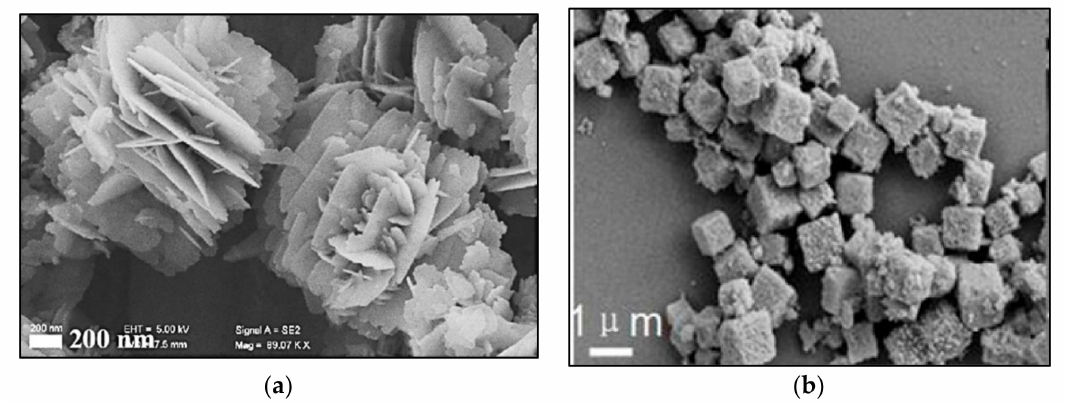
Figure 16. SEM images of ( a ) flower-like ZnO [91] ( b ) the cubic shaped of porous hollow ZnFe 2 O 4